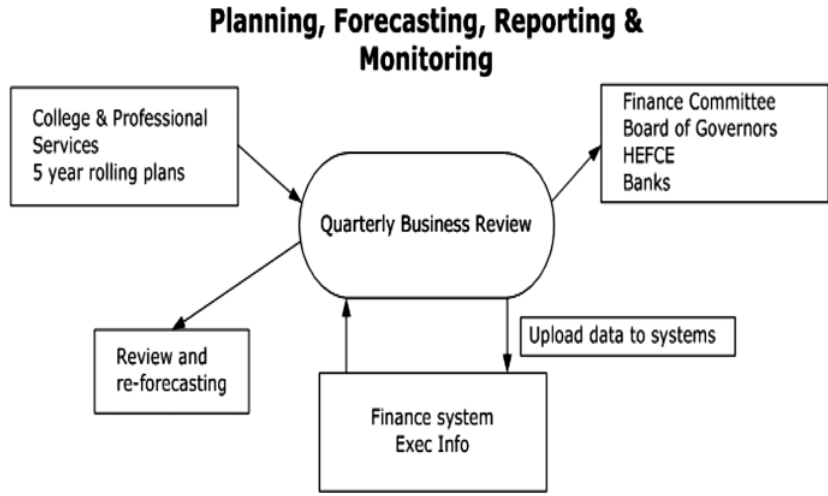
Figure 6. The quarterly business review